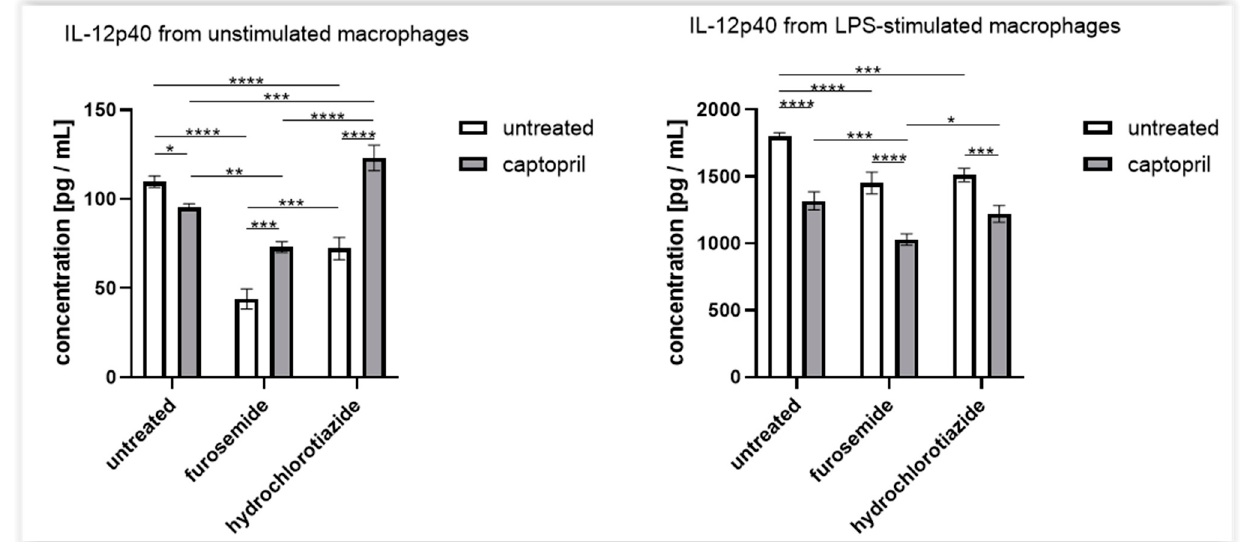
Figure 4. IL-12p40 secretion by macrophages harvested from drug-treated mice. Oil-induced peritoneal macrophages from mice treated with captopril with or without a respective diuretic drug were cultured in standard conditions, in some cases after stimulation with LPS (200 ng). Enzyme-linked immunosorbent assay (ELISA) was used to measure the concentration of IL-12p40 in supernatant collected after 24 h of the culture. Results were expressed as the mean (+/ − SD) per group. Two- way ANOVA with Tukey’s post hoc test. * p < 0.05; ** p < 0.01; *** p < 0.005; **** p < 0.001, n = 3, N =